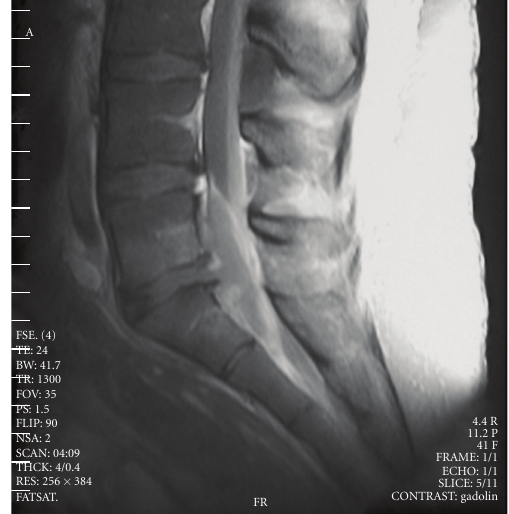
Figure 4: Sagittal T2-weighted, gadolinium-enhanced NMR imag- ing demonstrates enhancing epidural collection ventrally compress- ing the thecal sac opposite the L5-S2 vertebrae. The L5-S1 disk space is partially obliterated and the bony end plates enhanced, reflecting discitis and osteomyelitis